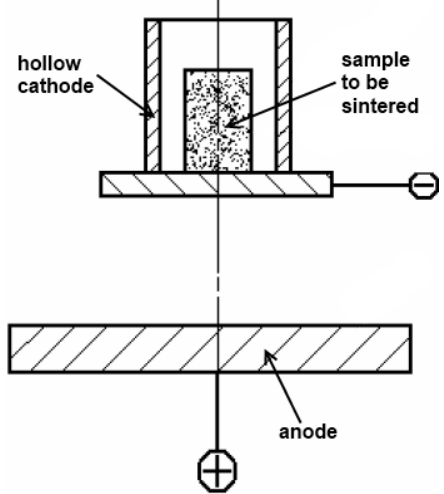
Figure 7. Schematic of the set-up for sintering in the plasma of a glow discharge.